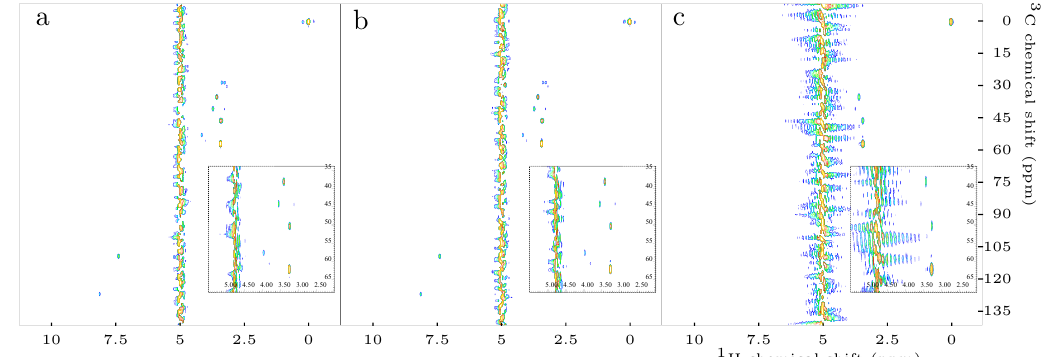
Figure 3. Exemplary 2D 1 H- 13 C-HSQC spectra obtained by means of: standard HSQC ( a ); Q-HSQC ( b ); and QUIPU-HSQC ( c ). Inserts depict the spectral regions of 70.0–35.0 and 5.5–2.0 ppm. A considerable number of signals stemming from aliphatic protons of the investigated metabolites is located in this region. Furthermore, the residual water signal at 4.78 ppm is located in this region, thus frequent overlap is